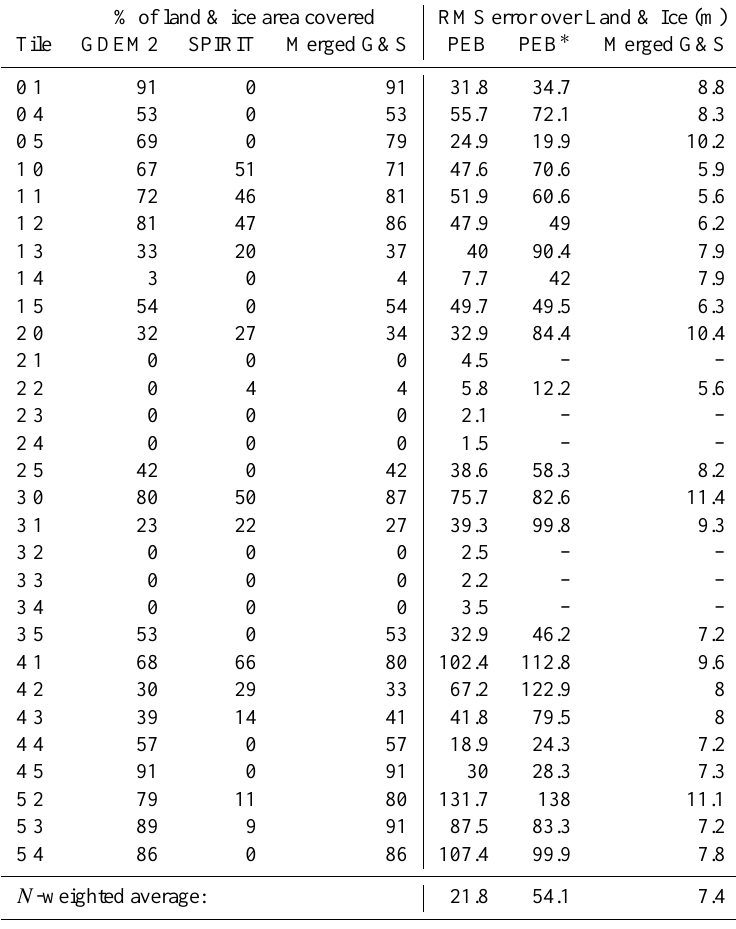
Table 1. Coverage and ICESat validation statistics for the data sets used in the GIMP DEM. Tile boundaries are delineated in Fig.